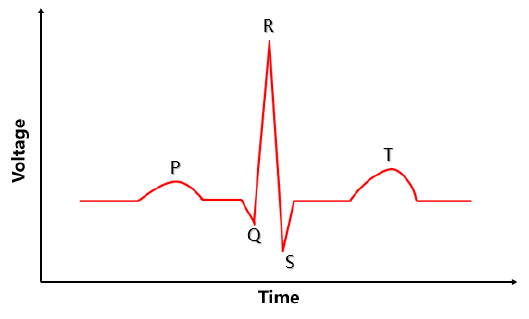
Figure 7. Electrocardiography.